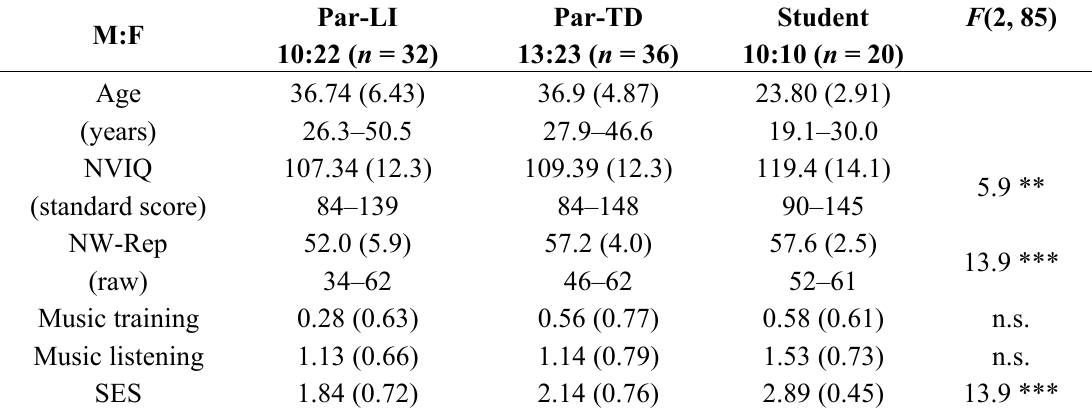
Table 4. Summary of means, and standard deviations (in parentheses) for demographic and cognitive data and different environmental factors. F -tests from a series of one-way ANOVAs testing for differences among the three group are reported, ** p <